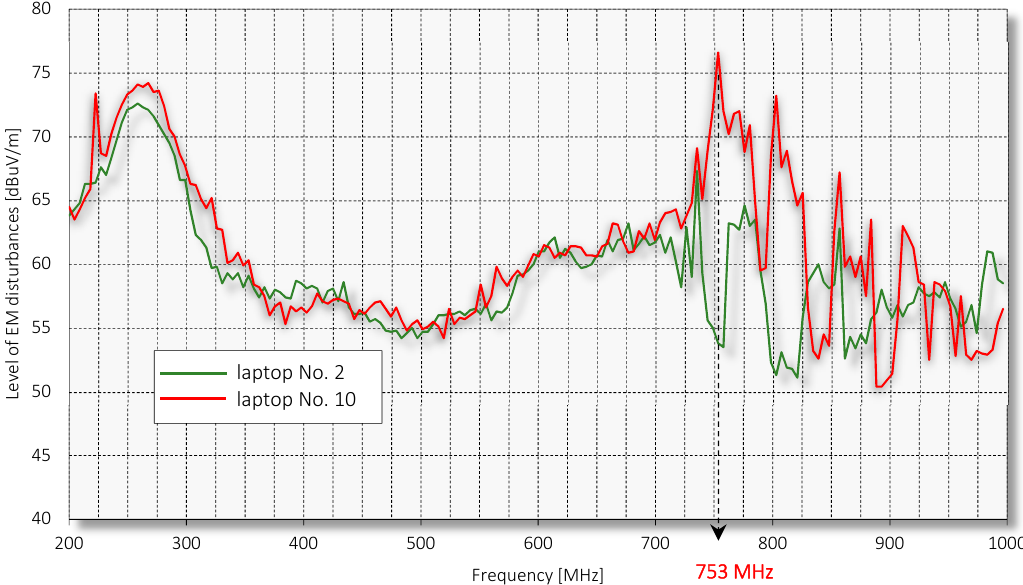
Figure 14. Levels of electromagnetic emissions from two selected laptops C and frequency of valuable emissions in the range of frequencies from 200 MHz to 1 GHz. Examples of reconstructed images using recorded sensitive emissions on frequency 753 MHz for two different laptops of C type are shown in Figure 15.